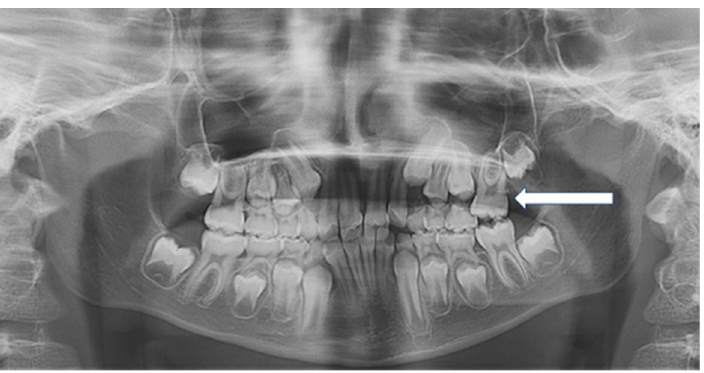
Figure 1. Panoramic radiograph showing unilateral ectopic eruption of the left permanent maxillary first molars (arrow) in a 7-year-old patient.